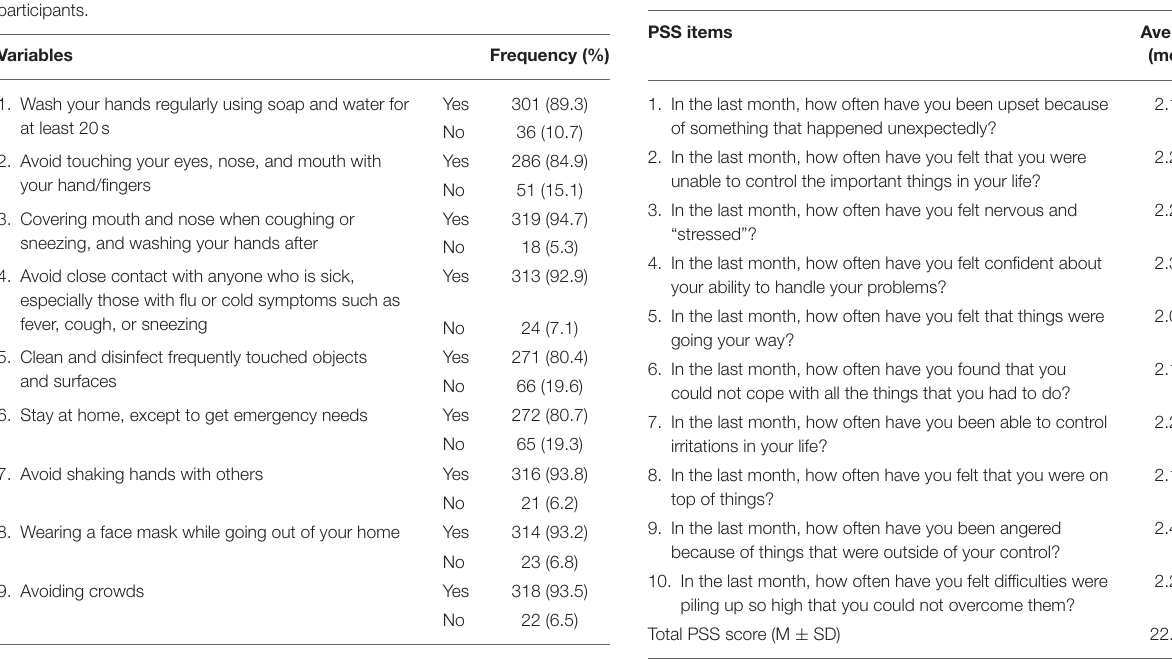
TABLE 4 | Perceived stress scale (PSS) among the participants.